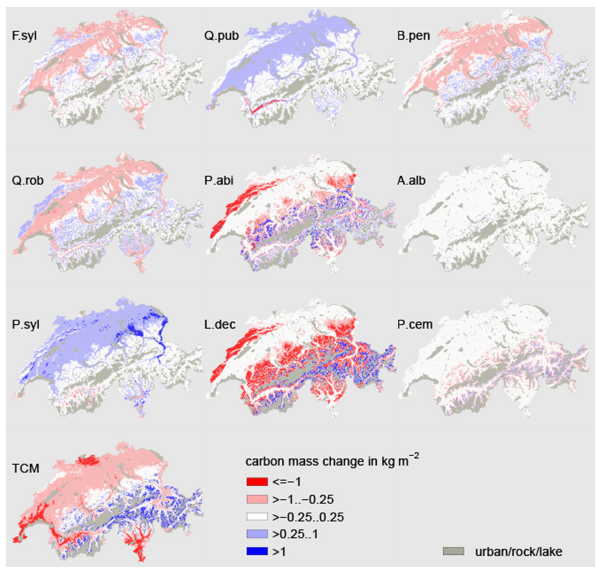
Figure 9. Changes in carbon mass between 2000 and 2100 simu- lated with the adjusted parameter set under a constant CO 2 level from year 2000 on. See Fig. 5 for species abbreviations. TCM: total carbon mass change. Compare to Figs. 7 and 8 for single species results under a rising CO 2 level, and to Fig. 4 for total carbon mass results under a rising CO 2